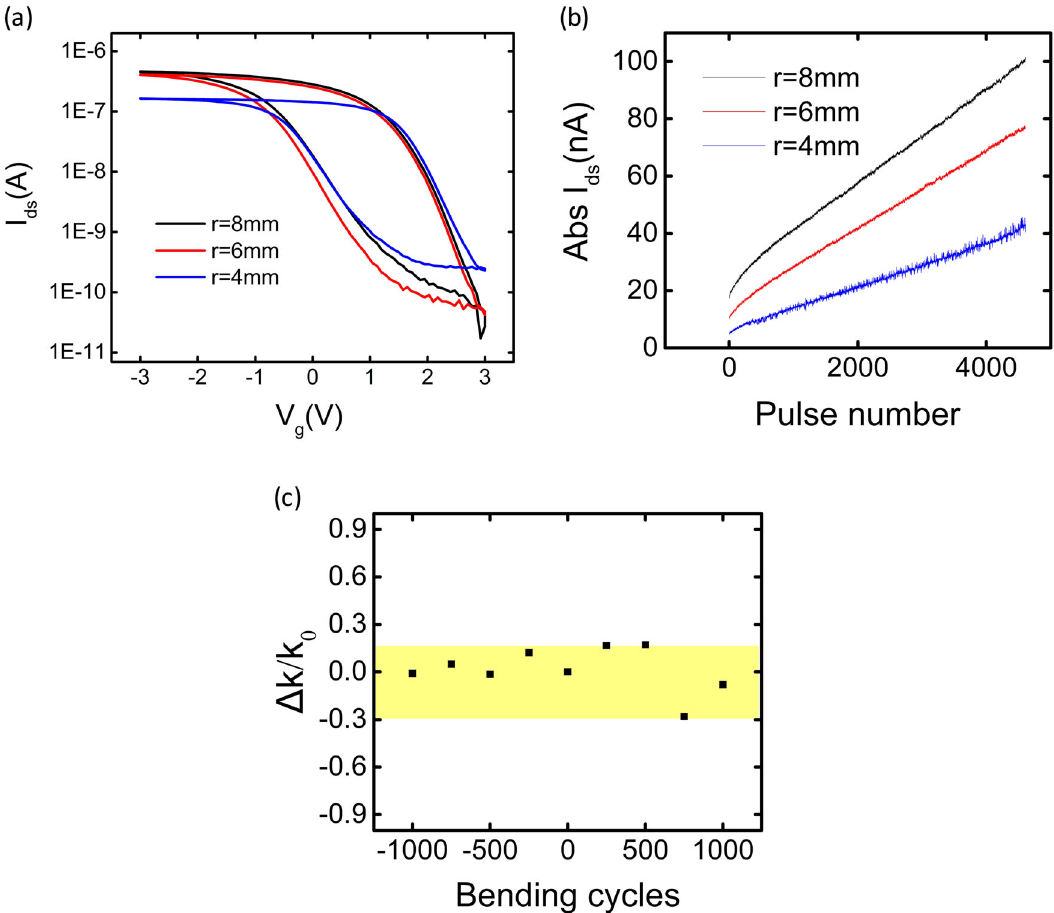
Fig. 5 Bending tests of the FMT. a I ds – V gs curve under different bending radiuses. b Response to consecutive identical pulses ( − 1 V, 10 ms pulse width, 15 ms period) at V g = 0.5 V. c Variation of the Δ I per pulse under repeated bending